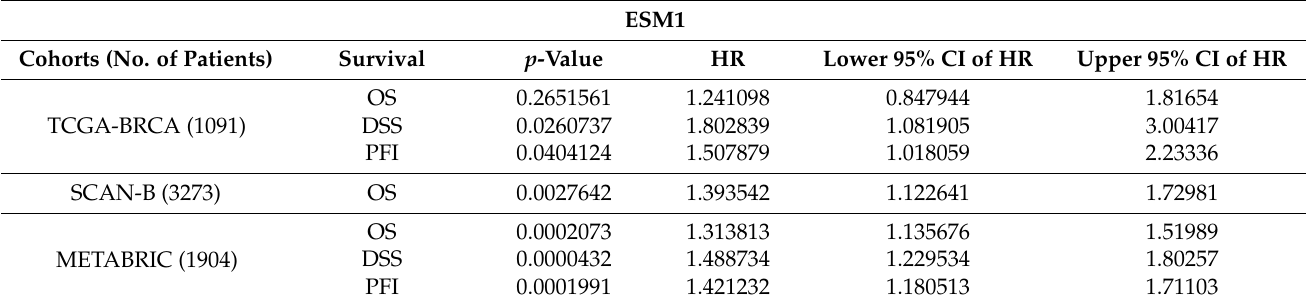
Table 1. ESM1 expression and survival data in breast cancer whole cohorts.